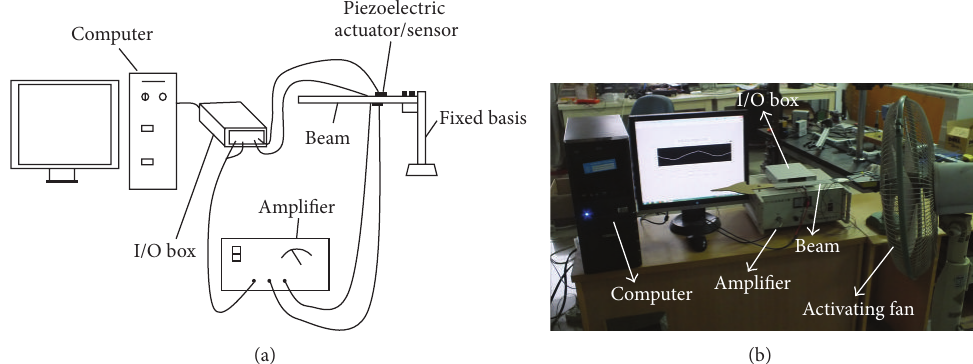
Figure 9: Diagram of the experiment setup (a), photograph of the testing system (b).